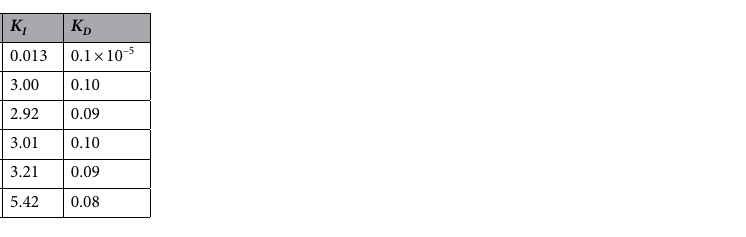
Table 5. The final optimized parameters of K P /K I /K D